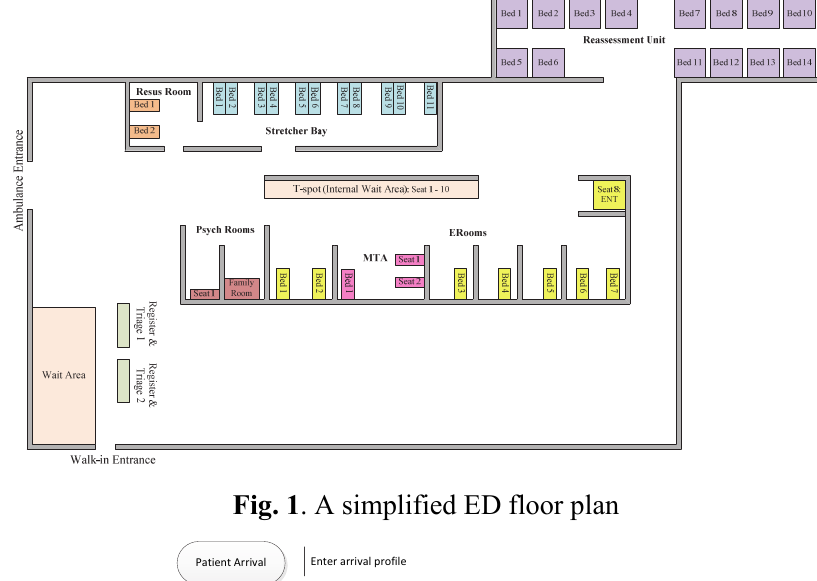
Fig. 1 . A simplified ED floor plan